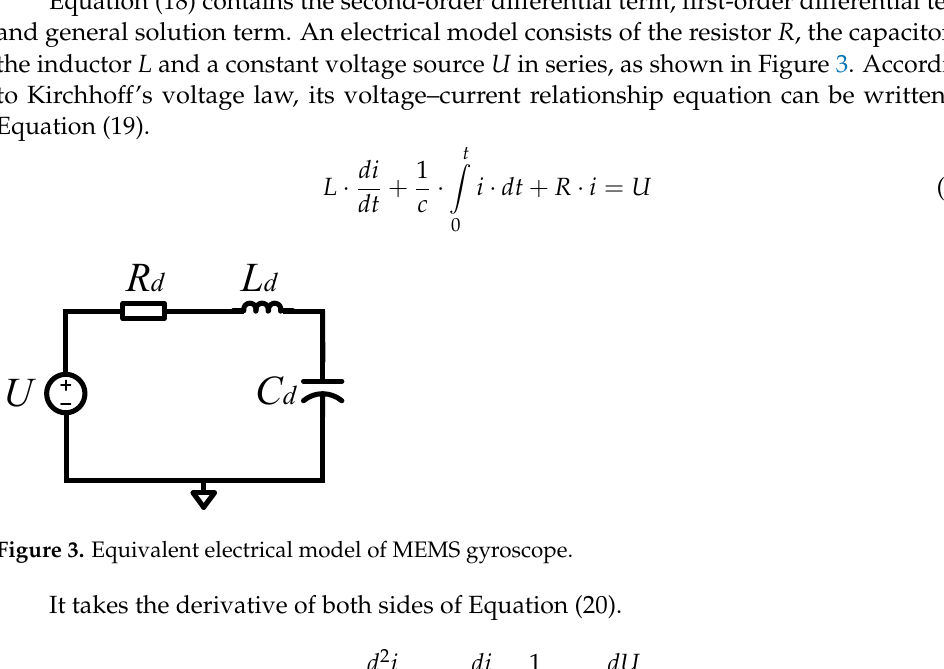
Table 1. Correspondence between gyroscope physical parameters and equivalent electrical param- eters.